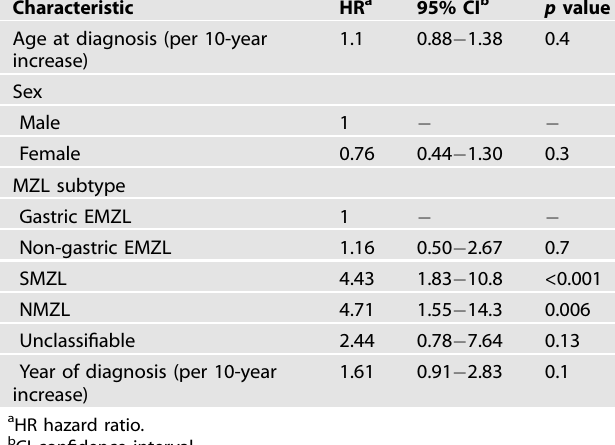
Table 1. The median age at diagnosis was 68 years for all MZL subtypes together (interquartile range (IQR), 58 − 77; range, 13 – 95), and there was a slight female predominance (59%). EMZL was the most frequent subtype, with 1070 cases (74%), followed by SMZL (186; 13%) and NMZL (91; 6.3%) cases, respectively. The MZL subtype could not be established in 107 (7.4%) of the cases. There were no clinically signi fi cant differences in median age at diagnosis between the males and females or in the MZL subtypes. The median follow-up time was overall 5.4 years (IQR, 2.0 − 10.4; range, 0 ‒ 24 years).